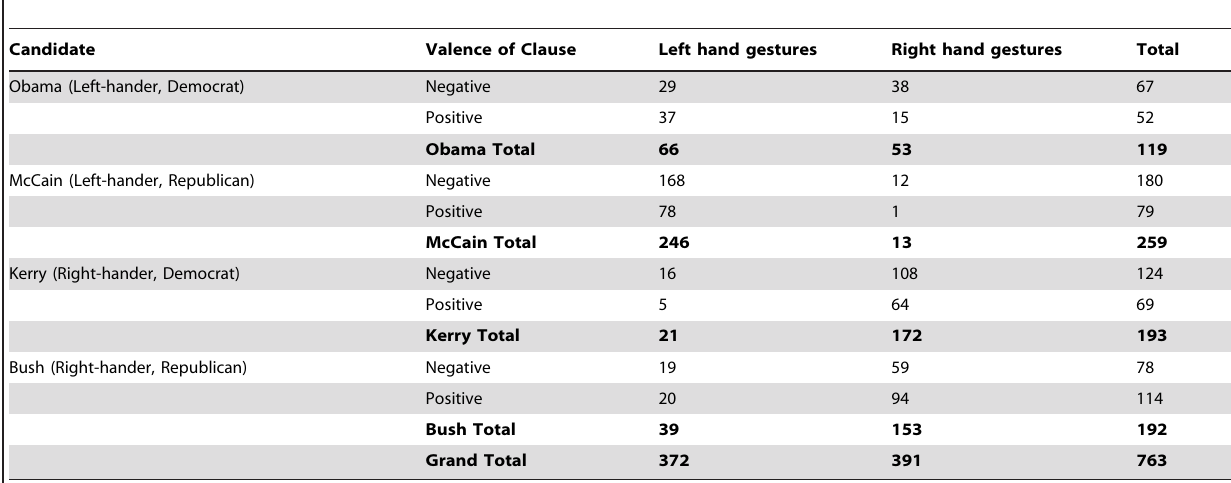
Table 1. Number of right- and left-hand gestures during clauses with positive and negative emotional valence.